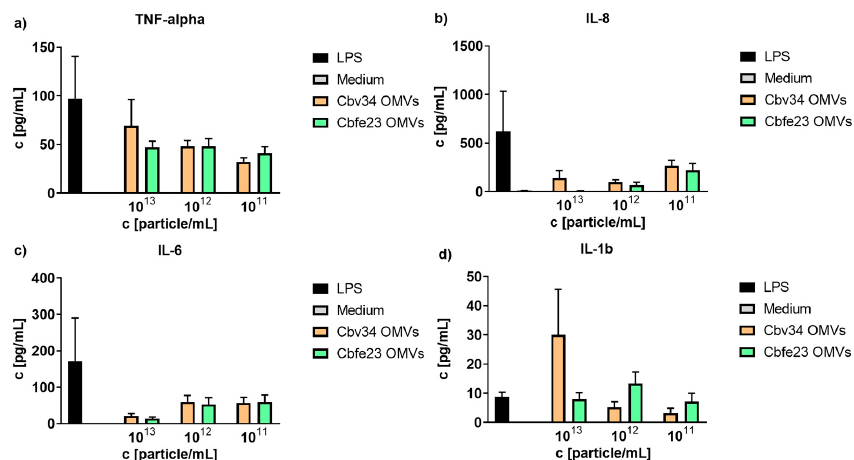
Figure 3. Cytokine detection of OMV-treated peripheral blood mononuclear cells (PBMCs). OMV-induced release of ( a ) TNF-alpha, ( b ) IL-8), ( c ) IL-6 and ( d ) IL 1-b at different concentrations. Mean ± SEM, n = 3.